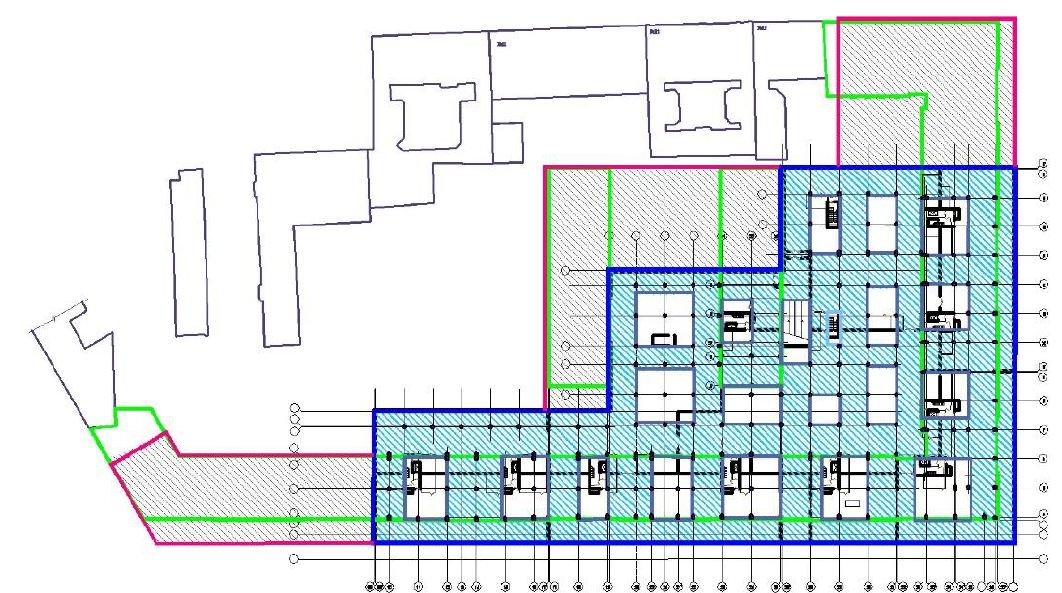
Figure 3. Arrangement of two-level underground rooms: monolithic reinforced concrete floor in the area of two-level underground structure at the bottom elevation of +1.81 and excavation of the second level to the